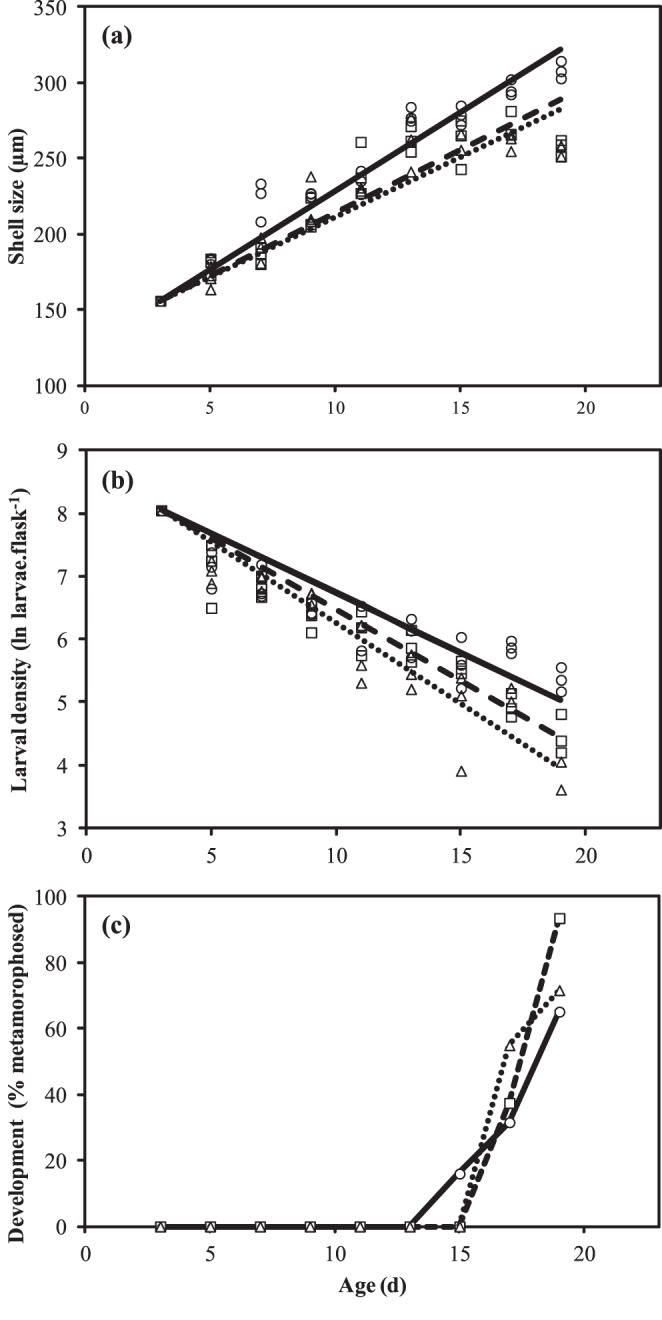

Macoma balthica: Ocean acidification effects on larval development.Shell length, survival and development stage of larvae between day 3 and day 19 of development reared at three seawater pH conditions: ∼pH8.1 (circles, solid line), ∼pH7.8 (squares, dashed line), and ∼pH7.5 (triangles, dotted line). Regression lines in (a) and (b) indicate average larval growth rate (µm.d−1) and mortality rate (d−1) for each treatment.